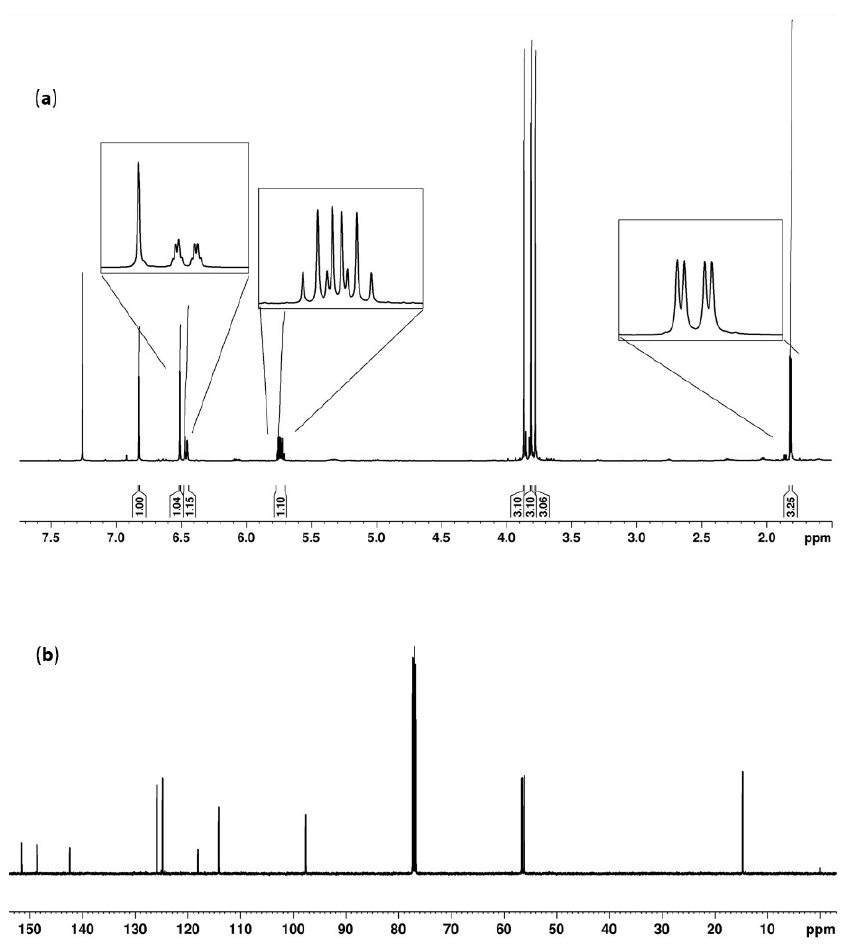
Figure 4. ( a ) 1 H-NMR (CDCl 3 , 400 MHz) and ( b ) 13 C-NMR (CDCl 3 , 100 MHz) spectra of asarone.